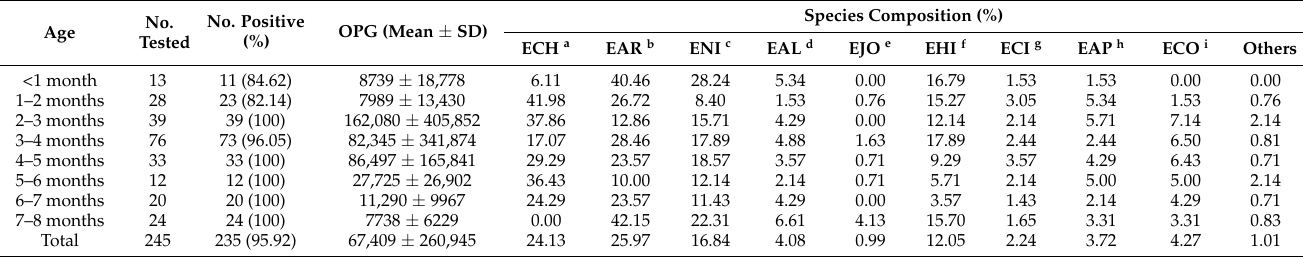
Table 1. Occurrence of Eimeria spp. and species composition in goats on Farm